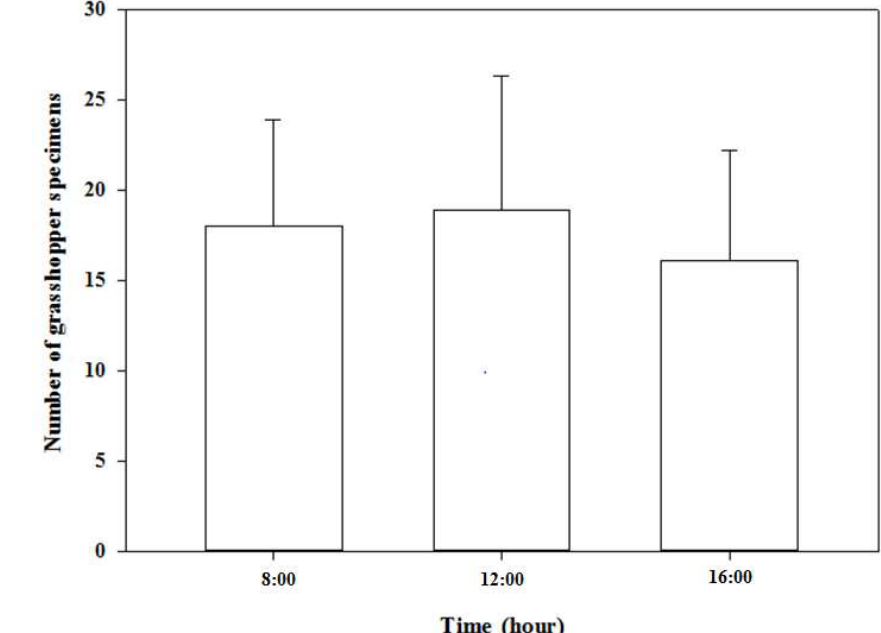
F IGURE 2. Mean±SE number of grasshoppers specimens captured in different times of day at two rangeland sites in